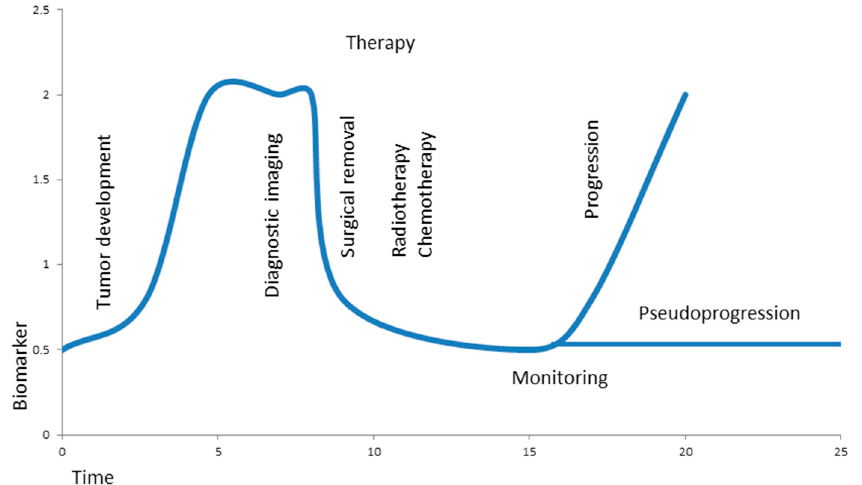
Figure 2. Hypothetical biomarker during brain tumor development, therapy, and monitoring. A growing tumor causes elevated levels of a biomarker at time of diagnostic imaging; the levels drop significantly after surgical removal of the tumor and stay low during additional radio- and chemotherapy. Liquid biopsy allows minimally invasive, real-time monitoring in order to differentiate progression from pseudoprogression of the tumor.